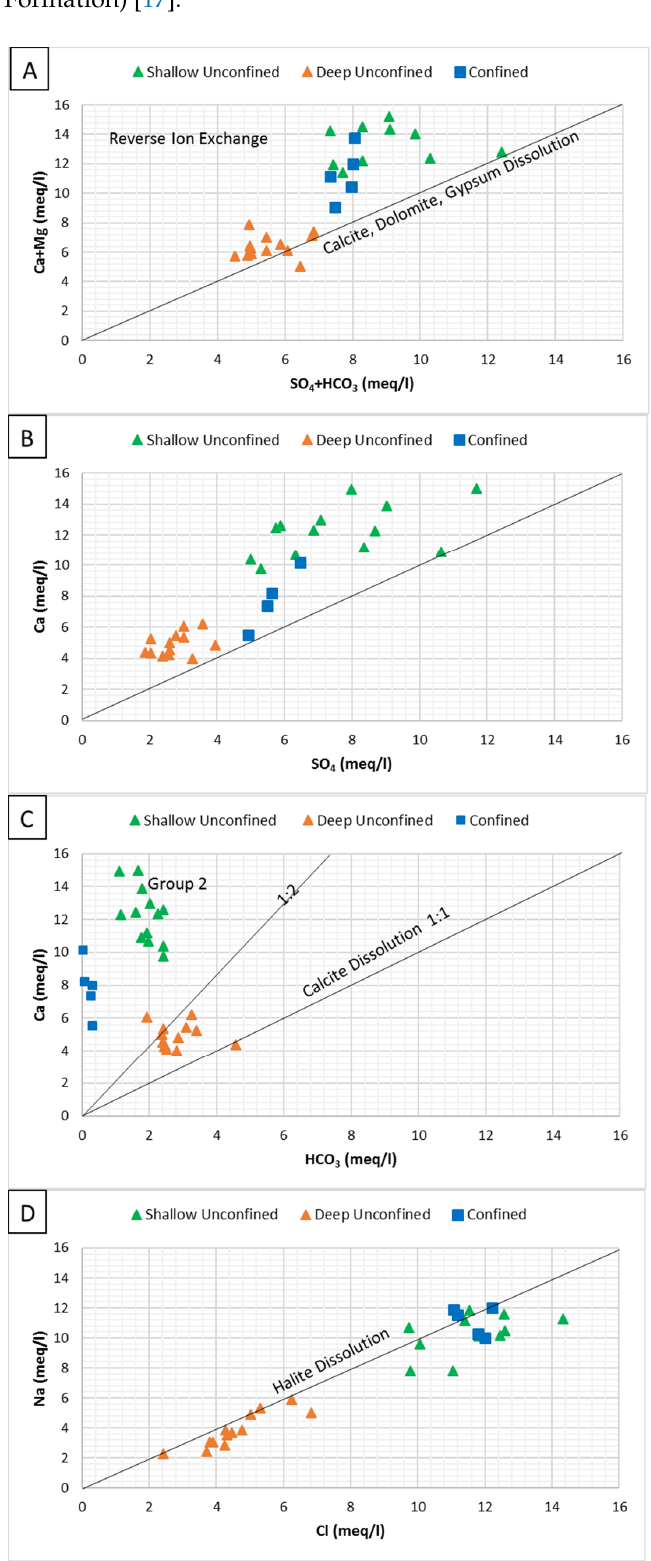
The plagioclase mineral comes from the Wajid sandstone (particularly from Khusayyayn Formation) [17].